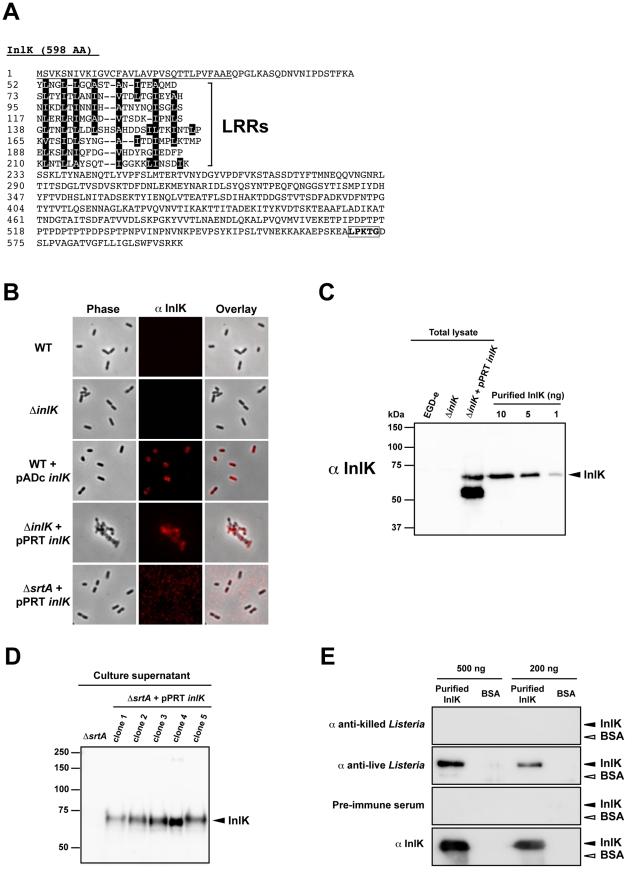
InlK is expressed in vivo.A. InlK amino acid sequence. The signal sequence is underlined and the different regions of leucine rich repeats (LRRs) are outlined. The consensus pentapeptide LPXTG at the C-terminal end is boxed. B. Detection by immunofluorescence microscopy of InlK over-expressing in L. monocytogenes EGD-e (WT), ΔinlK, WT+pADc-inlK, ΔinlK+pPRT-inlK and the ΔsrtA mutant over-expressing inlK (ΔsrtA+pPRT-inlK) grown in BHI medium using the rabbit polyclonal anti-InlK antibody. InlK was detected at the surface of InlK over-expressing bacteria (WT+pADc-inlK and ΔinlK+pPRT-inlK), whereas it was undetectable at the surface WT bacteria or at the surface of the ΔstrA mutant over-expressing inlK. C. Detection of InlK by Western blot on total lysates of L. monocytogenes EGD-e (WT), ΔinlK and ΔinlK+pPRT-inlK grown in BHI using the rabbit polyclonal anti-InlK antibody. Decreased concentrations of recombinant purified InlK were used as a positive control. D. Detection of secreted InlK in the supernatant of ΔsrtA mutants over-expressing InlK. Western blotting was carried out on trichloroacetic acid precipitates of ΔsrtA and ΔsrtA+pPRT-inlK culture (OD600 = 1) supernatants using the rabbit polyclonal anti-InlK antibody. E. Detection of purified recombinant InlK protein with rabbit polyclonal anti-live Listeria antibody, rabbit polyclonal anti-killed Listeria antibody, rabbit polyclonal anti-InlK and a rabbit pre-immune serum. InlK was detected only with the rabbit polyclonal anti-live Listeria antibody indicating that it is expressed during the in vivo infectious process. BSA was used as control protein. Two different amounts of proteins were tested (500 ng and 200 ng) to access signal specificity.